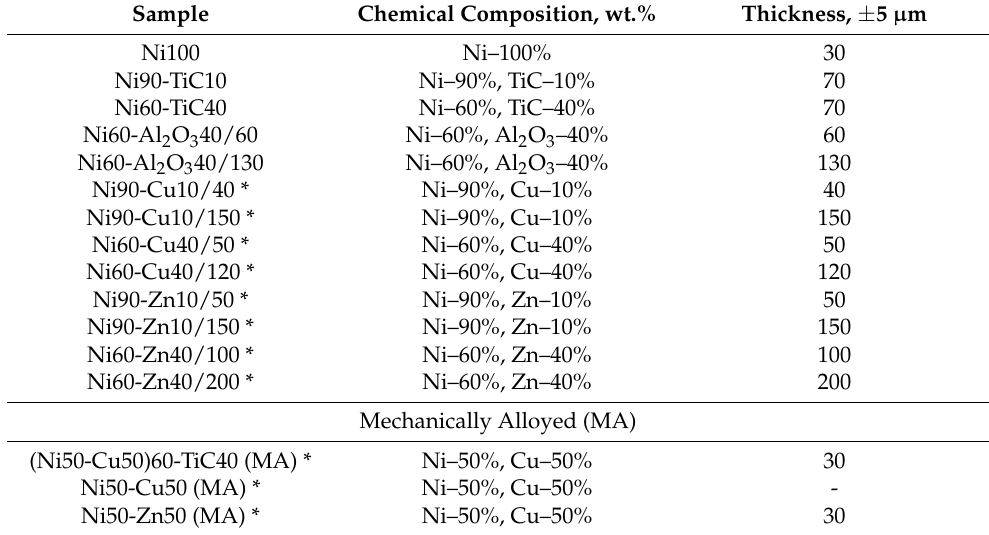
Table 1. Composition and thickness of the applied